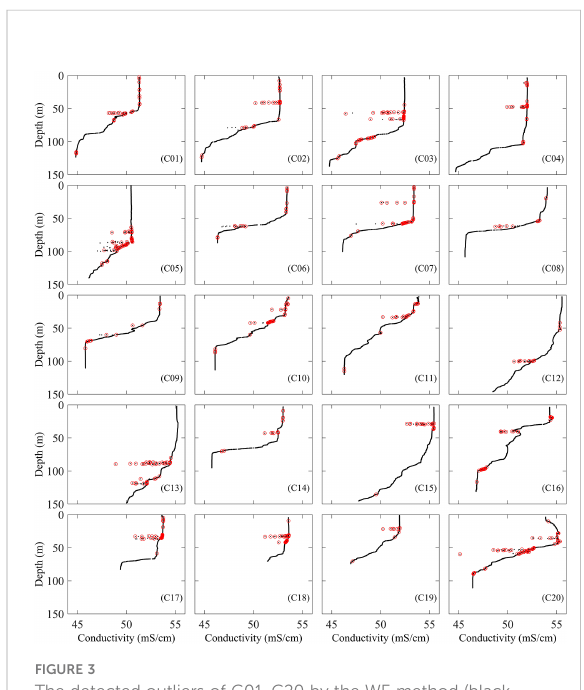
FIGURE 3 The detected outliers of C01-C20 by the WE method (black points are the original data, and red points are the detected outliers).